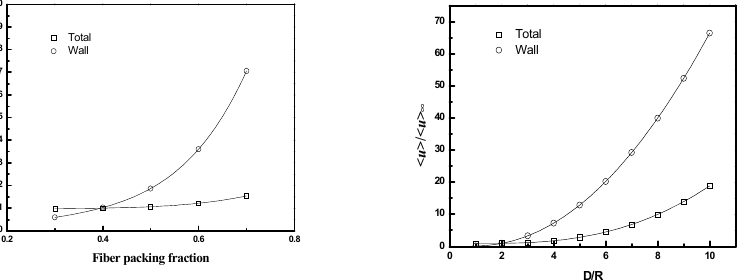
Figure 11. <u>/<u> ∞ as a function of fiber number for the whole flow channel (Total) and the channel adjacent to the wall (Wall): (top, left ) ɸ = 0 .4, D/R f = 2, (top, right ) ɸ = 0 .6, D/R f = 2, and (bottom) ɸ = 0 .4, D/R f = 3.